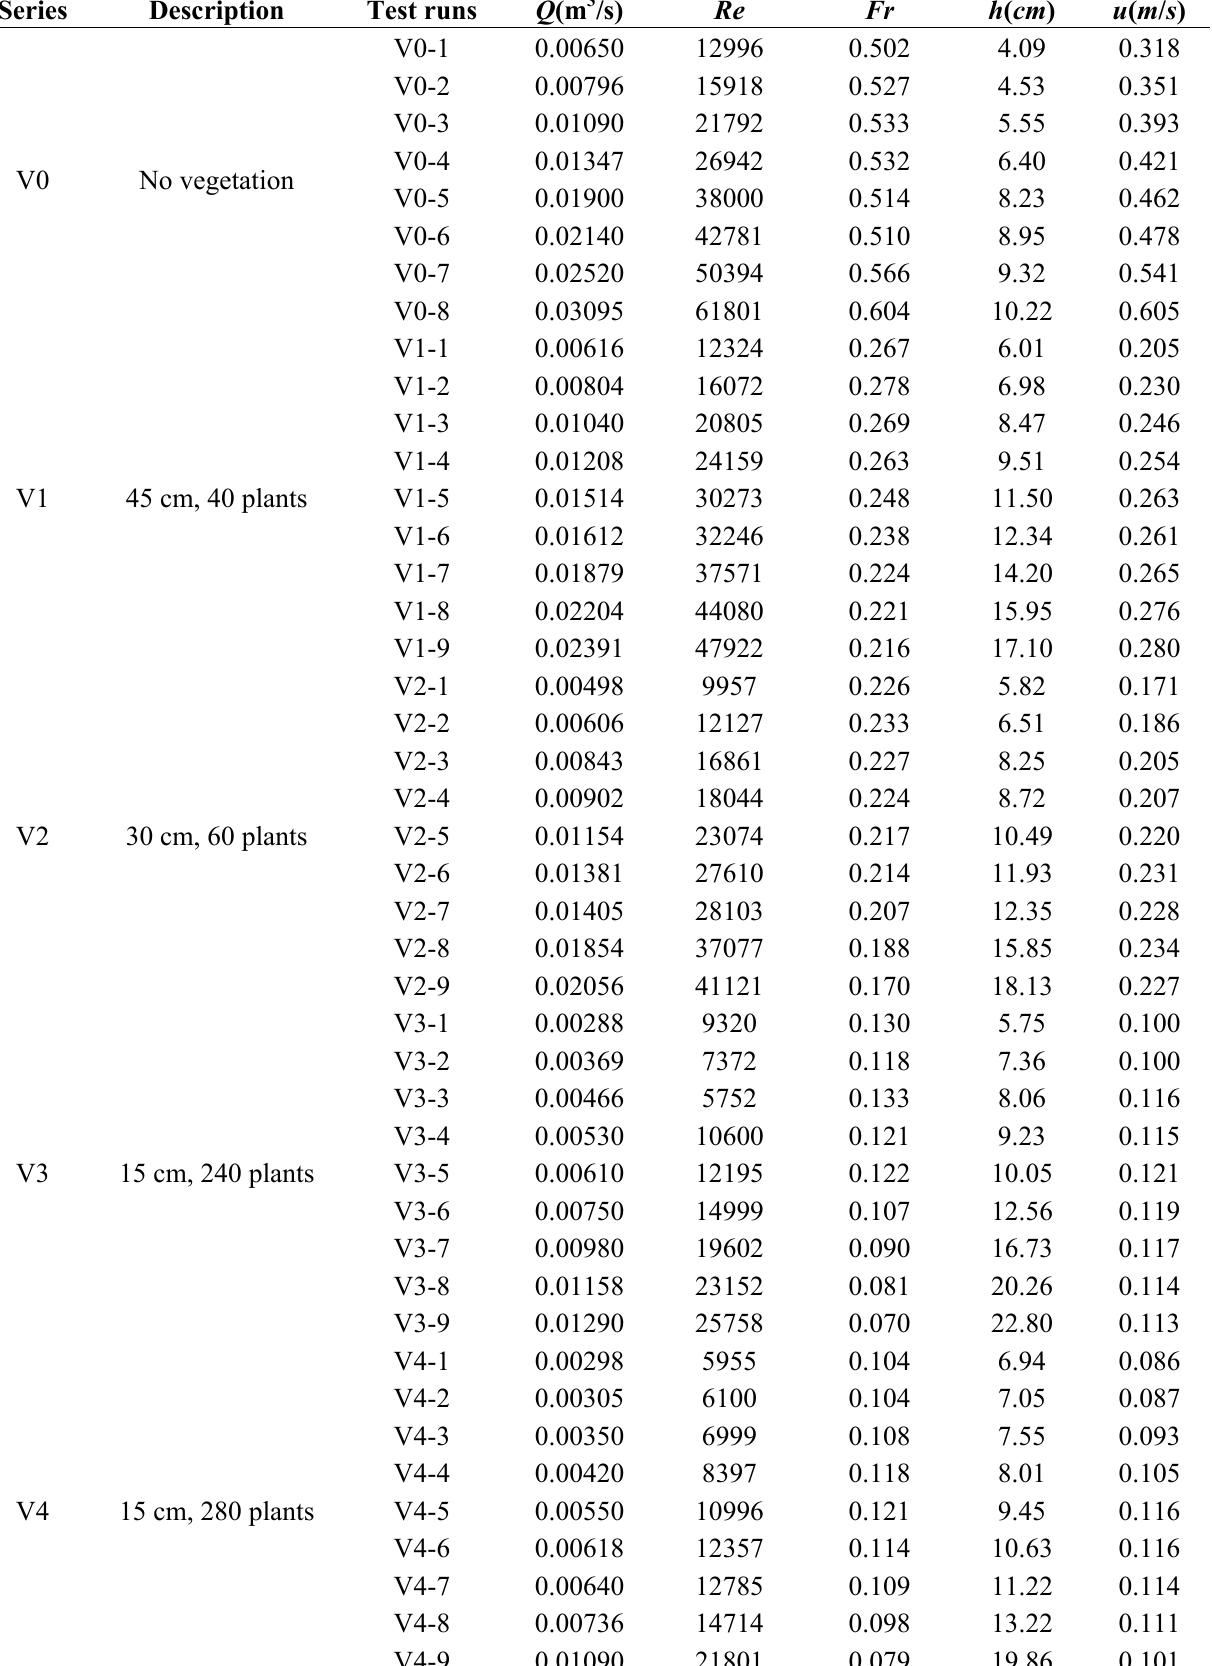
Table 1. Summary of experiments for vegetation density